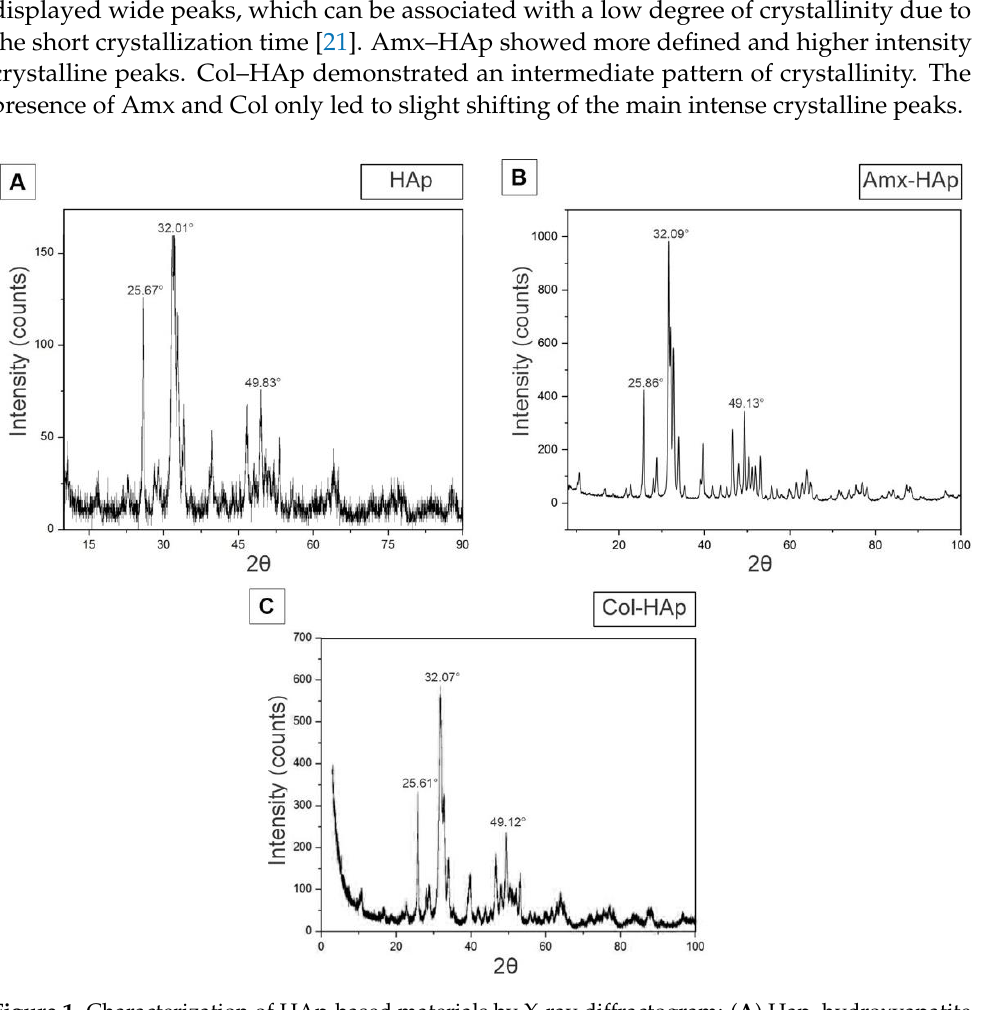
Figure 1. Characterization of HAp-based materials by X-ray diffractogram: ( A ) Hap, hydroxyapatite nanosheet-assembled microspheres; ( B ) Amx–Hap, amoxicillin–hydroxyapatite composite; ( C ) Col– HAp, collagen–hydroxyapatite composite.